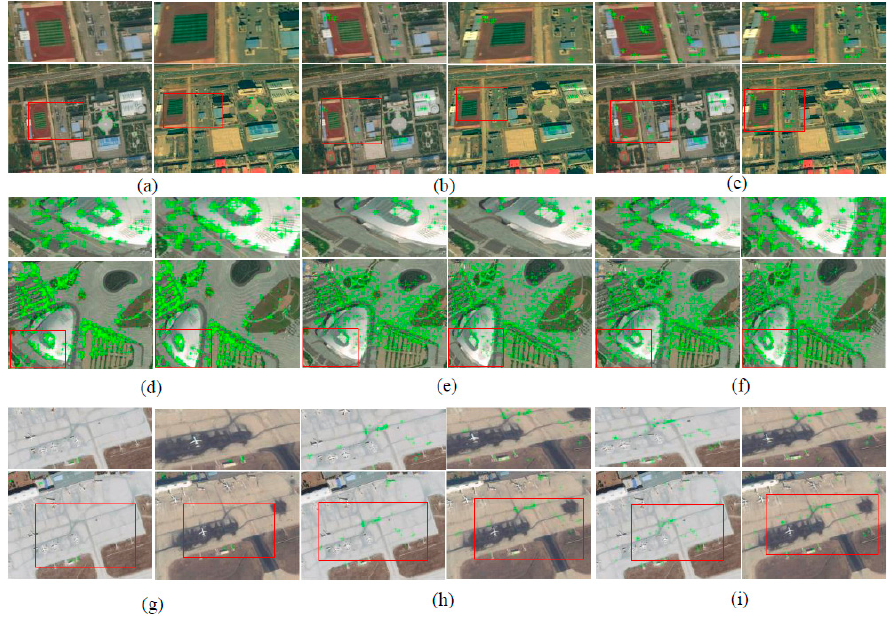
Figure 10. Matching results of the three methods tested on satellite stereo images WX1–3. ( a , d , g ) tested on ASIFT. ( b , e , h ) tested on Brown-AffNet. ( c , f , i ) tested on SJRS-AffNet.